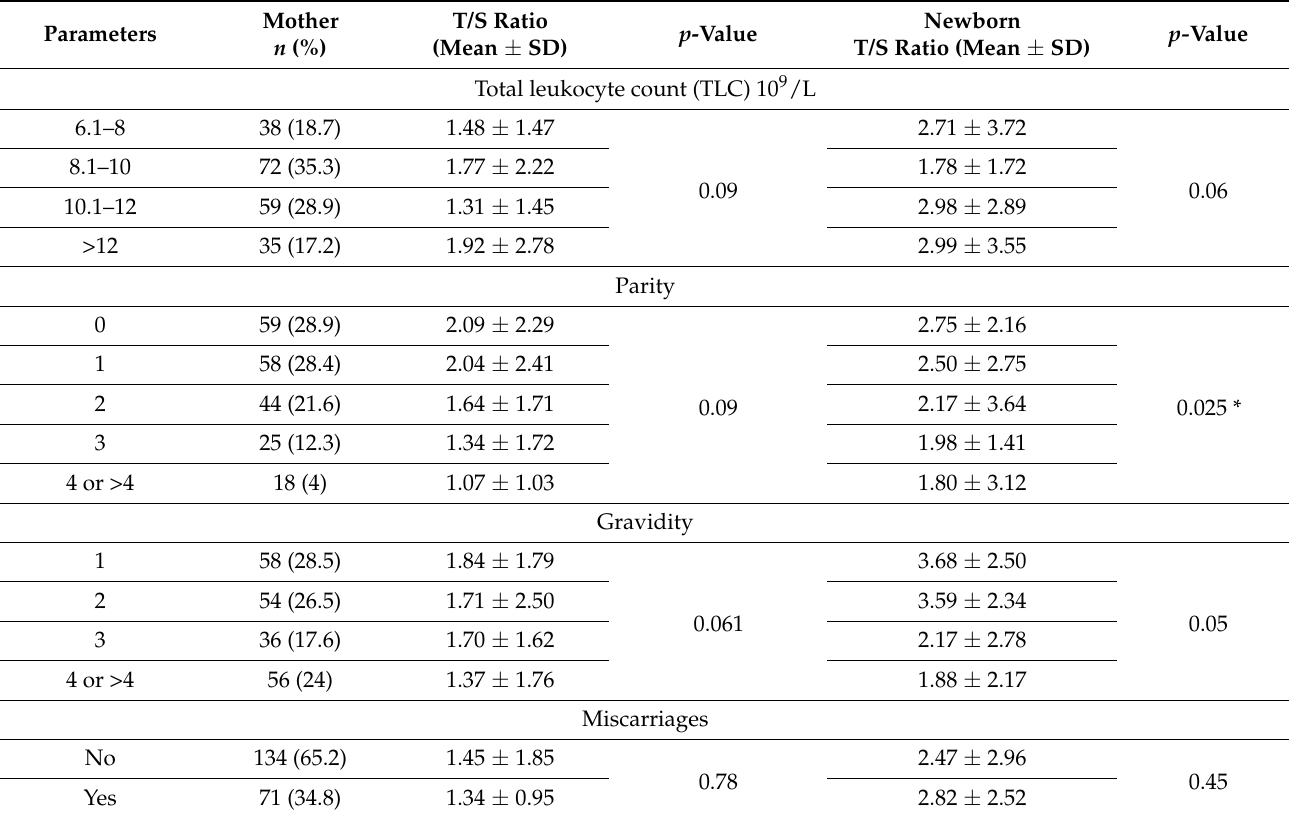
Table 3. Difference between telomere length (TL) among newborn gender. Parameters